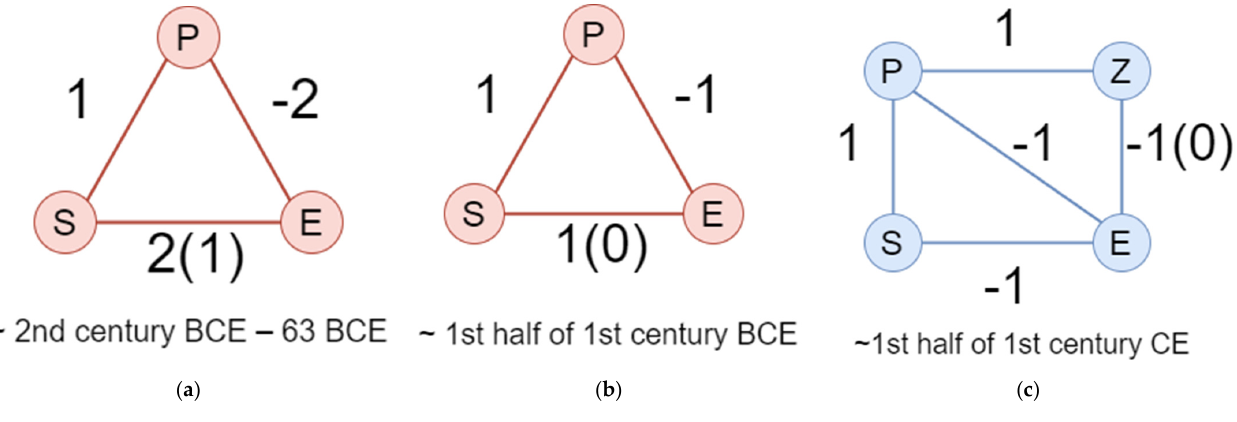
Figure 4. Visualization of the relations between Judaean sects during the period 2nd century BCE–74 CE. The vertices are denoted S (Sadducees), P (Pharisees), E (Essenes), and Z (Zealots). The panels illustrate the relations during different periods: ( a ) the period from the 2nd century BCE to the advent of the Romans in Judea in 63 BCE; ( b ) the first half of the 1st century BCE; ( c ) the period from 6 BCE until 74 CE.